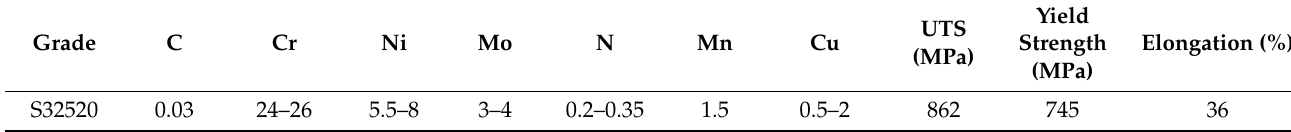
Table 2. Chemical composition and mechanical properties of the base